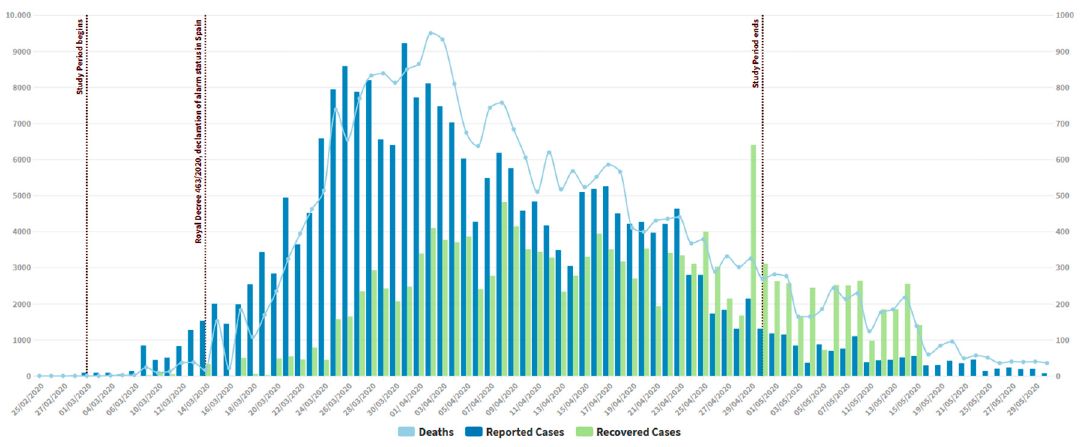
Figure 1. The daily evolution of reported cases, deaths, and recovered cases from the COVID-19 pandemic in Spain. Source: Ministry of Health of the Government of Spain [23].